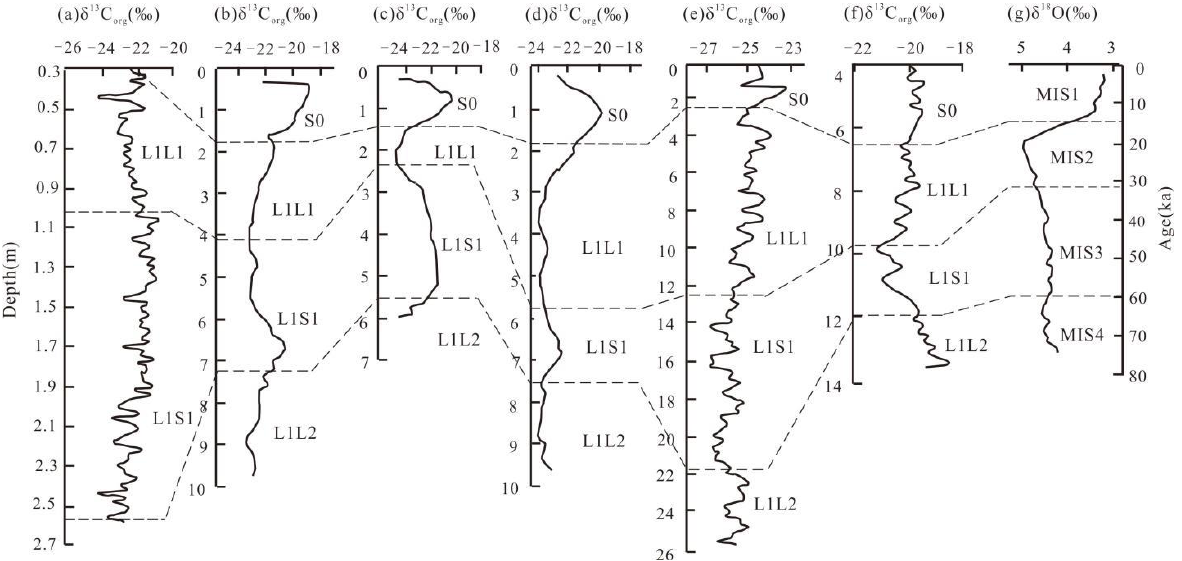
Figure 5. Vertical distribution characteristics of ( a ) δ 13 C org records of CQS section; ( b ) Luochuan loess section [40]; ( c ) Lantian loess section [40]; ( d ) Xunyi loess section [46]; ( e ) Yuanbao loess section